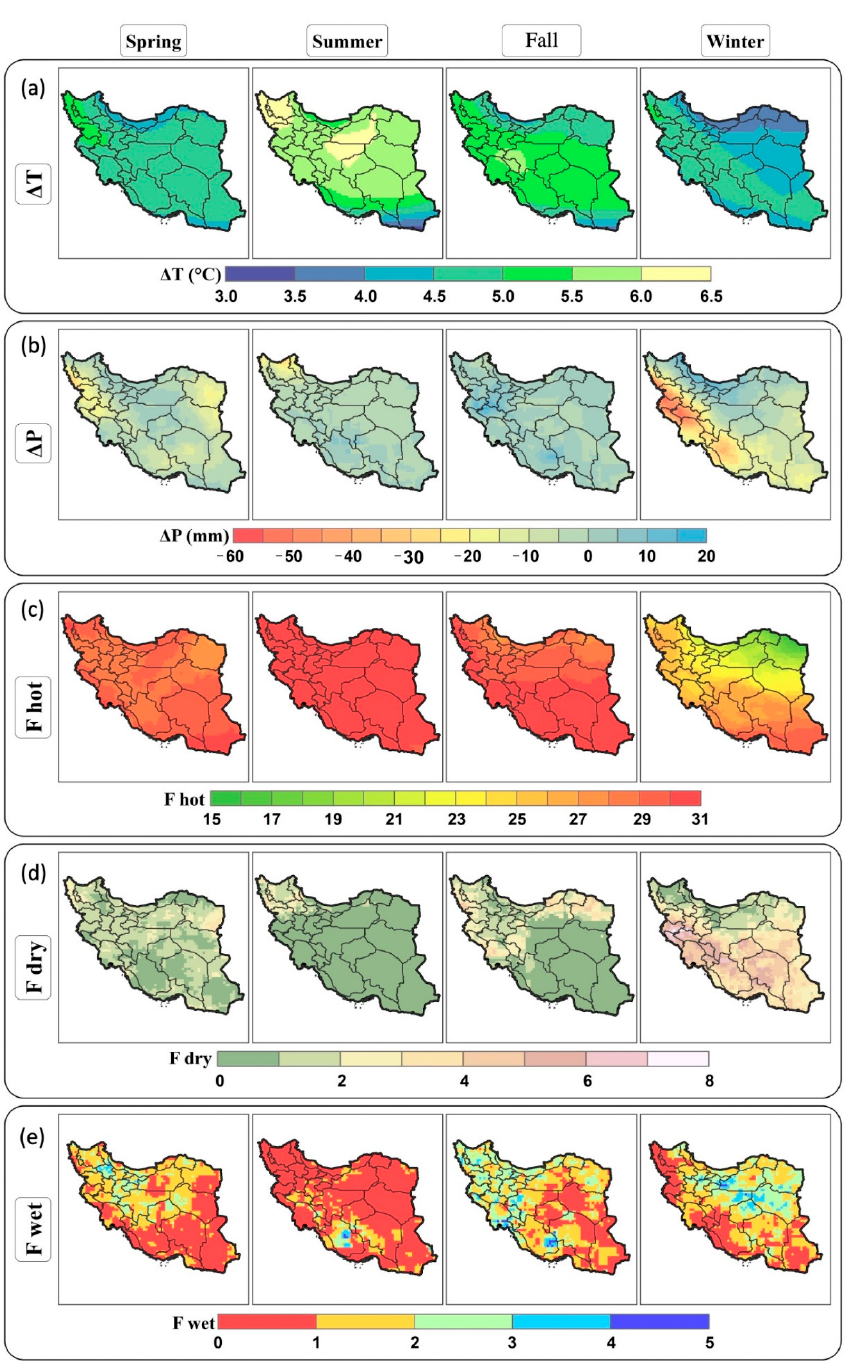
Figure 5. Variations in climate change indicators over Iran for RCP8.5 during 2070–2100 period (unitless). ( a ) Seasonal temperature difference ( Δ T), ( b ) seasonal precipitation difference ( Δ P), ( c ) seasonal temperature occurrences (F hot ), ( d ) frequency of extreme dry seasons (F Dry ) and ( e ) wet season frequency (F Wet ).